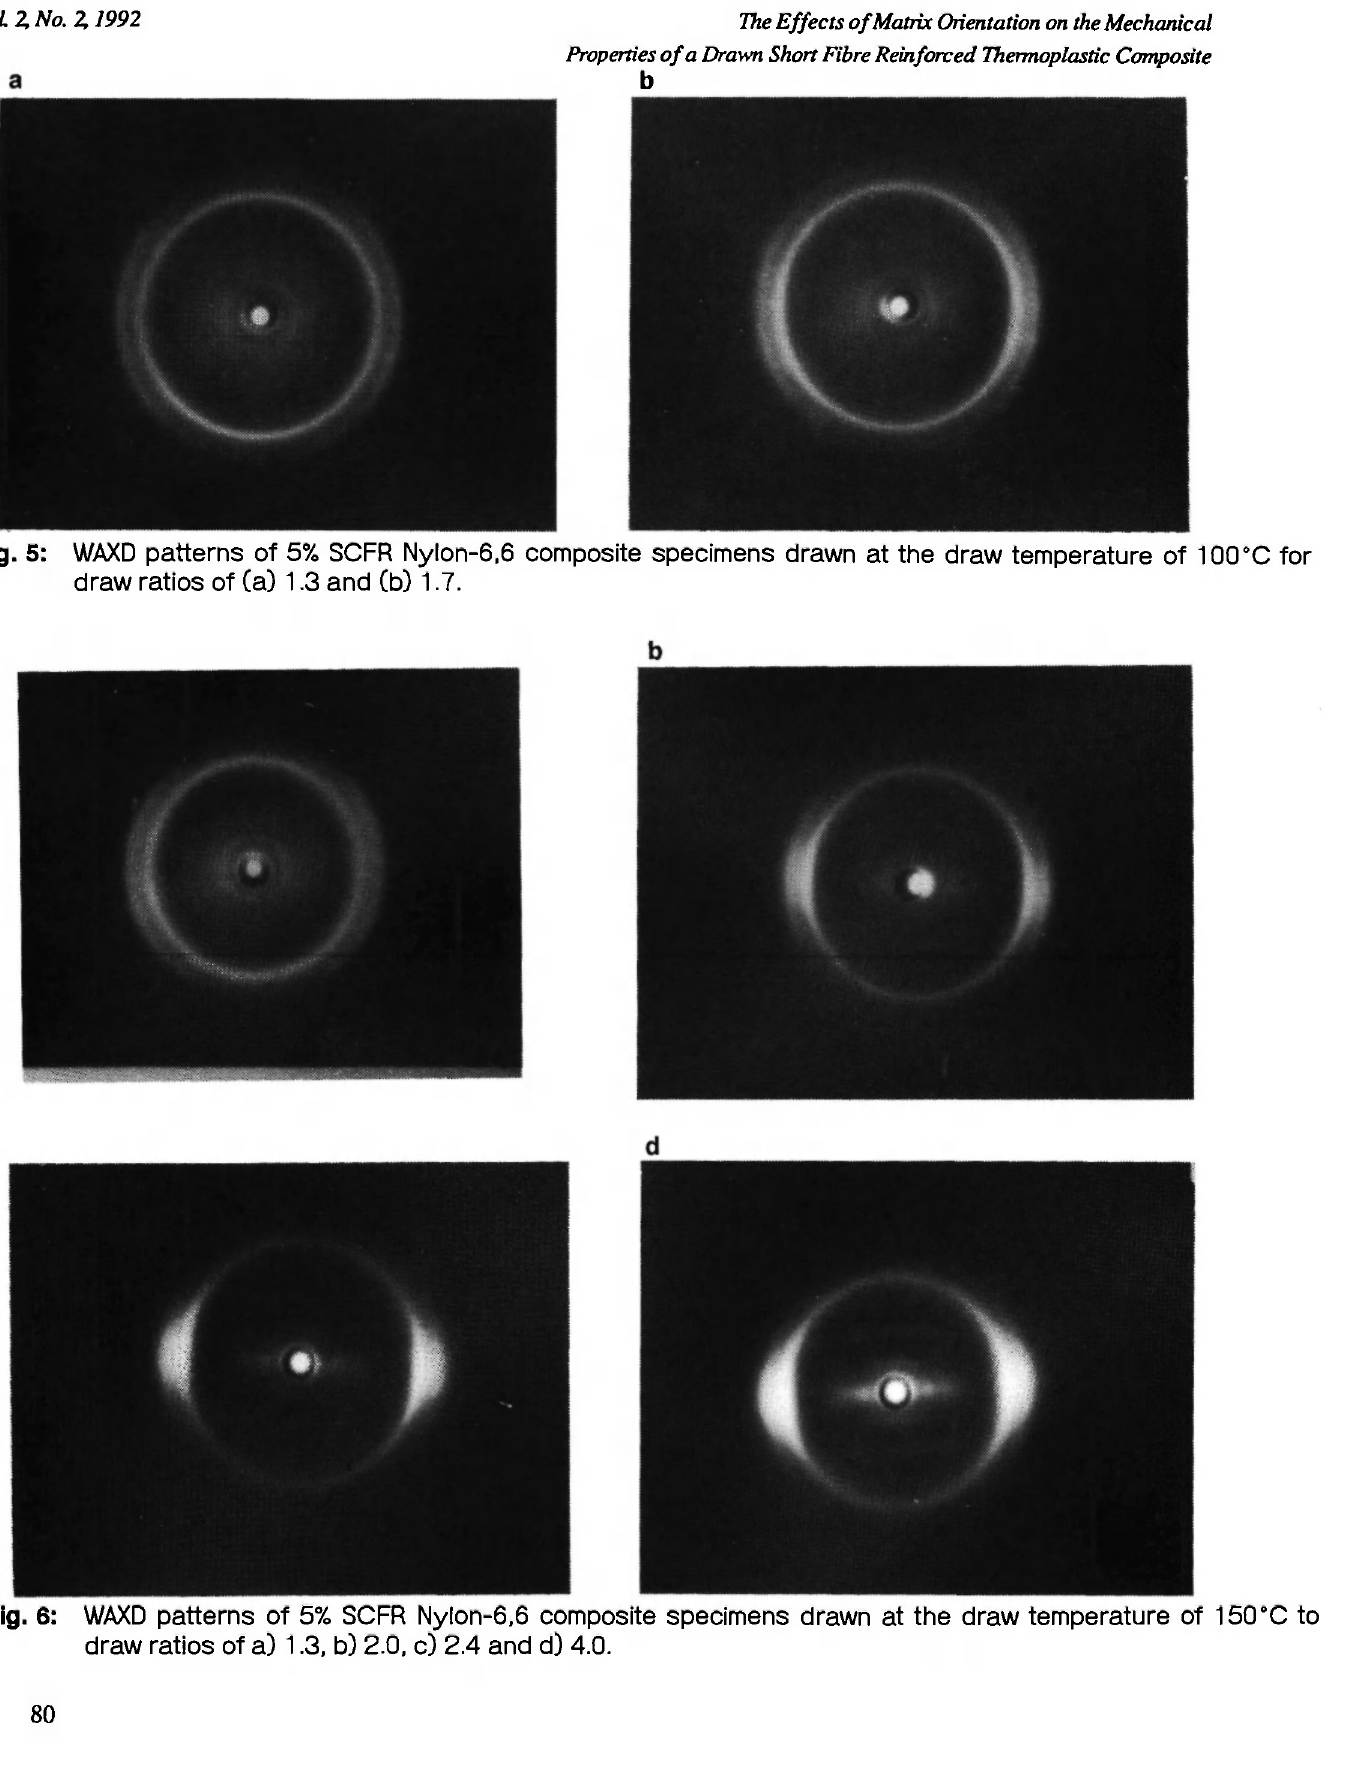
Fig. 6: WAXD patterns of 5% SCFR Nylon-6,6 composite specimens drawn at the draw temperature of 150°C draw ratios of a) 1.3, b) 2.0. c) 2.4 and d) 4.0.